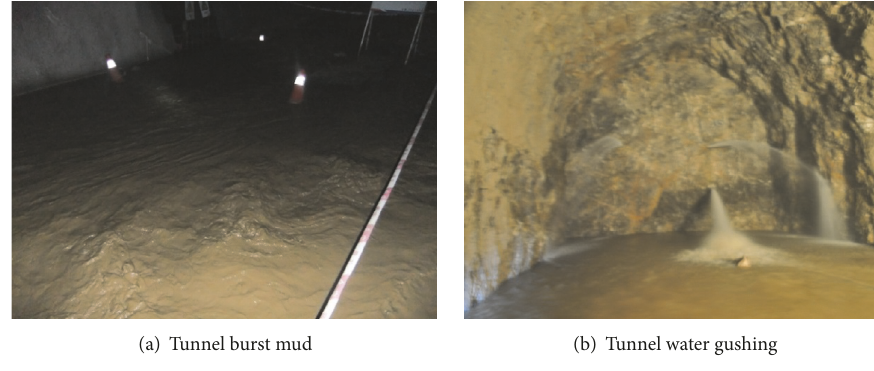
Figure 2: Research section tunnel site water and mud inrush.